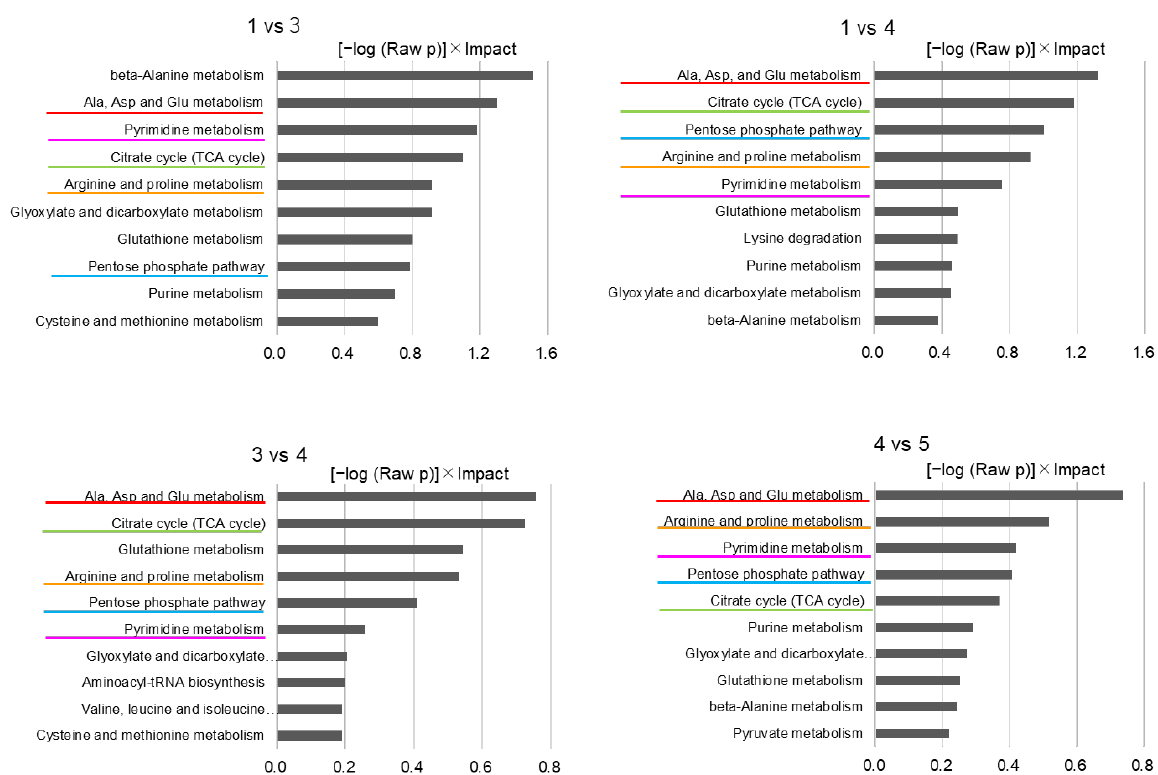
Figure 4. Metabolome changes in MDA231 by indirect coculture with astrocytes. ( A ) Treatment group was shown. 1—MDA231 cultured in DMEM; 2—MDA231 cultured in 3 µ M Glu; 3—MDA231 performed indirect coculture with 50% diluted astrocytes culture supernatant; 4—MDA231 performed indirect coculture with astrocytes exposed to 3 µ M Glu; 5—MDA231 performed indirect coculture with astrocytes exposed to 3 µ M Glu and 100 µ M of TBOA (EAAT inhibitor). ( B ) Heat map of clustering analysis. The red square metabolites show significant changes in groups 3, 4, and 5 in common compared with group 1. ( C ) 2D plot of principal component analysis (PCA). Numbers show each treatment group. ( D ) A pathway extracted by metabolome enrichment analysis derived from metabolites that contributed 50% to the first principal component (PC1) component of PCA. The bar length indicates the value of “( − log (Raw p )) × Impact” in descending order. ( E ) 2D plot of PCA is shown with an arrow attached between each of the two groups. Comparison of each of the two groups was performed by metabolome enrichment analysis derived from metabolites selected by volcano plot. The bar length indicates the value of “( − log (Raw p )) × Impact” in descending order.